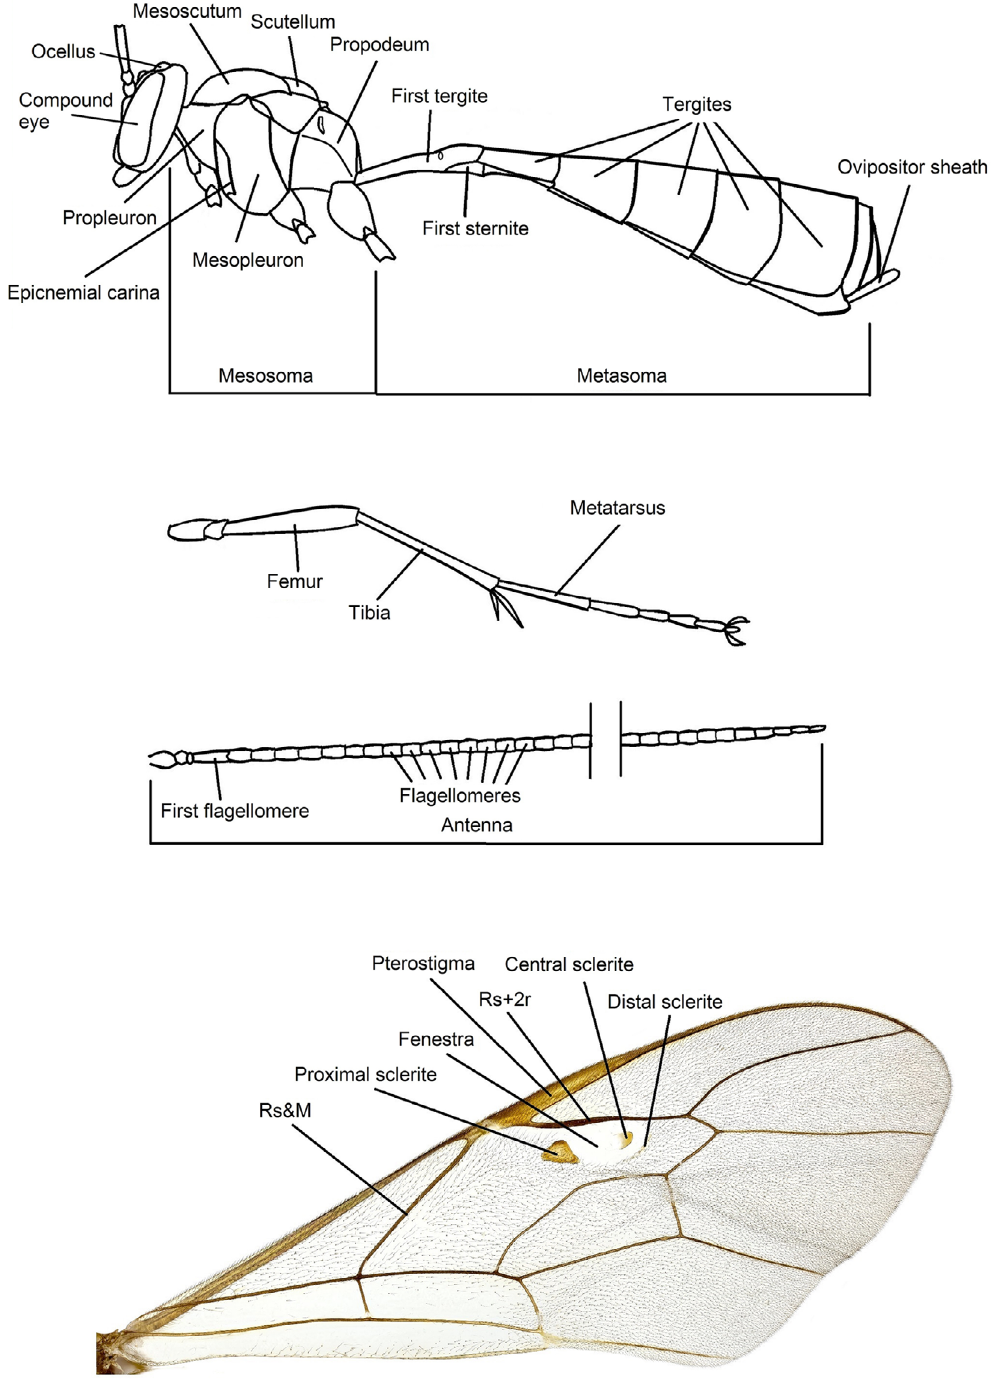
Fig. 1. Morphological terminology referred to in the